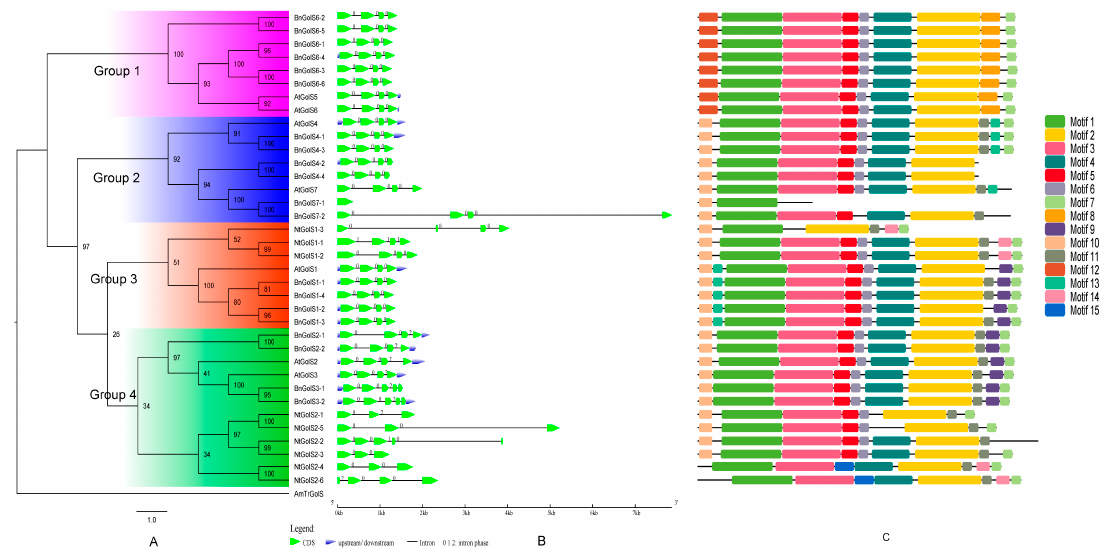
Figure 1. Phylogenetic, gene structure and conserved motifs of GolS proteins in A. thaliana , B. napus and N. tabacum . ( A ) Amino acid sequences of AtGolS, BnGolS and NtGolS were aligned using MUSCLE. The phylogenetic tree was constructed with the online PhyML server with bootstrap analysis (100 replicates) and displayed using FigTree v1.4.0. The 36 GolS proteins from A. thaliana , B. napus and N. tabacum (GolS in A. trichopoda as an outgroup) clustered into four distinct groups; ( B ) Gene structures were generated by the Gene Structure Display Server. Exons (CDS) and introns are shown with green wedges and black lines, respectively. Numbers 0, 1 and 2 represent the introns in phases 0, 1 and 2, respectively. The scale bar represents 1.0 kb. At: A. thaliana ; Bn: B. napus ; Nt: N. tabacum ; AmTr: A. trichopoda . ( C ) Conserved motifs in AtGolS, BnGolS and NtGolS proteins were identified by MEME. A colored box indicates the different motifs that are numbered along the bottom.